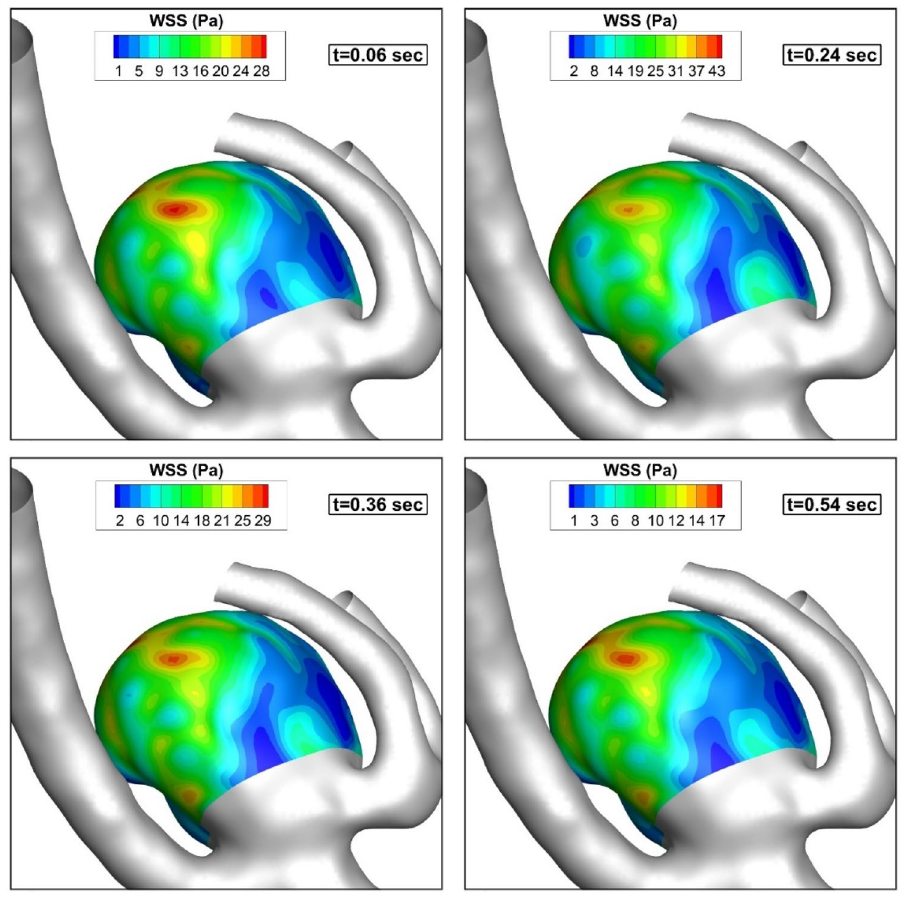
Figure 5. WSS contour (hct = 0.40 without coiling (porosity =